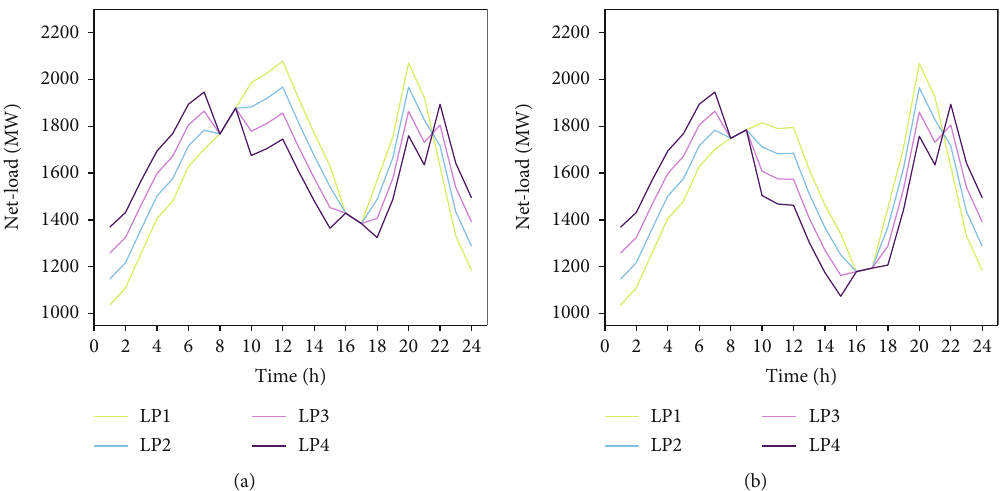
Figure 6: Net load curves of the load pro fi les (LPs) for (a) 10% and (b) 30% solar penetration levels and abundant solar resource conditions.